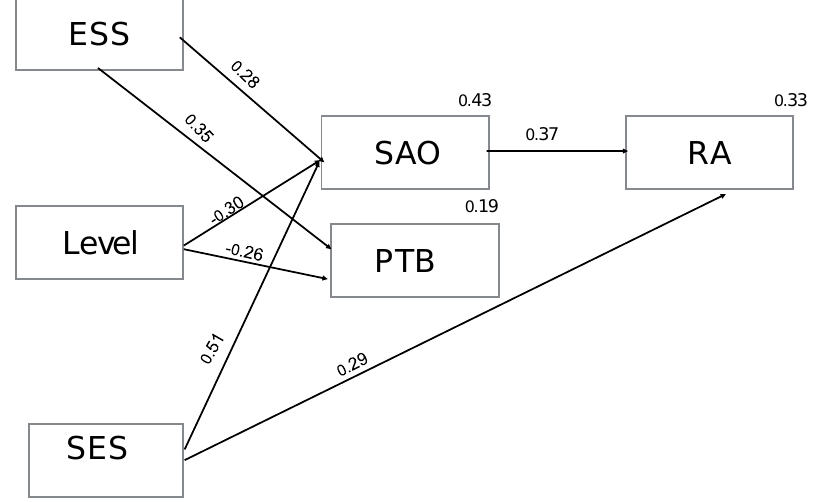
Figure 1. Final Model: ESS, SAO PTB and RA with significant